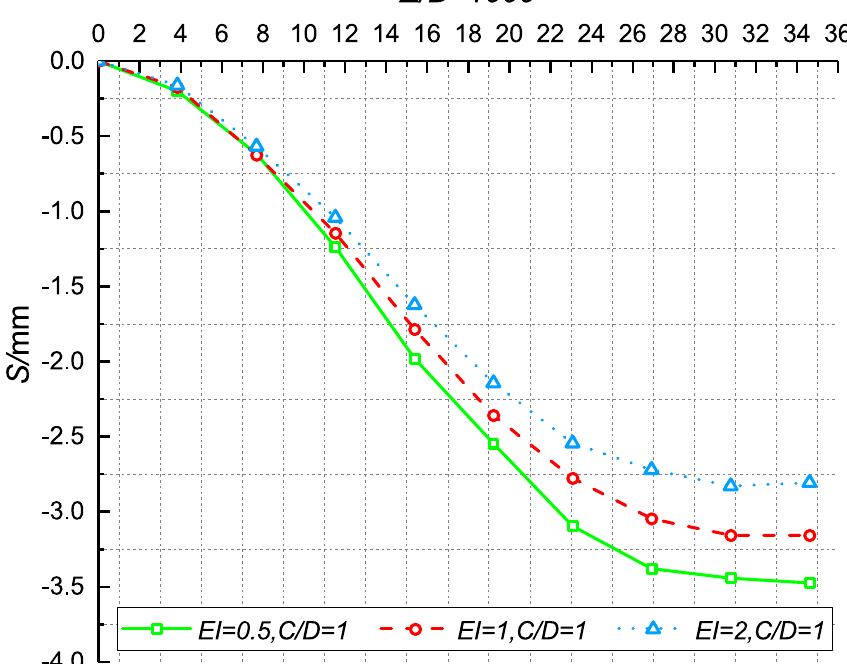
Figure 12. Variation of the maximum pipe deformation with the excavation face displacement.